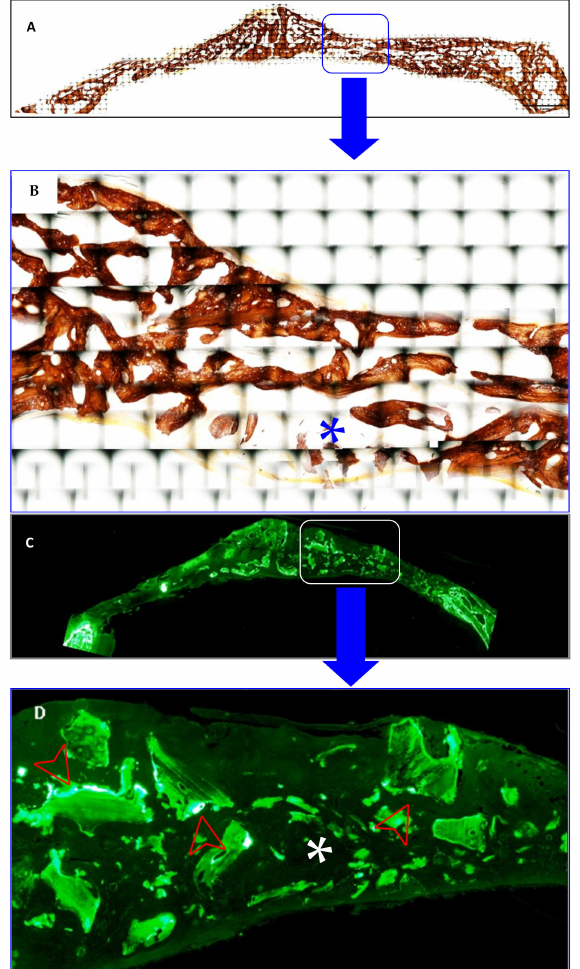
Figure 5. Images of histological sections made using Von Kossa ( A , B ) and fluorescence staining ( C , D ) after 3 weeks. Blue and white asterisks indicate new bone formation in the defect. Red pointers indicate areas of calcein deposition around the bone defect. The images present a calibration of 2